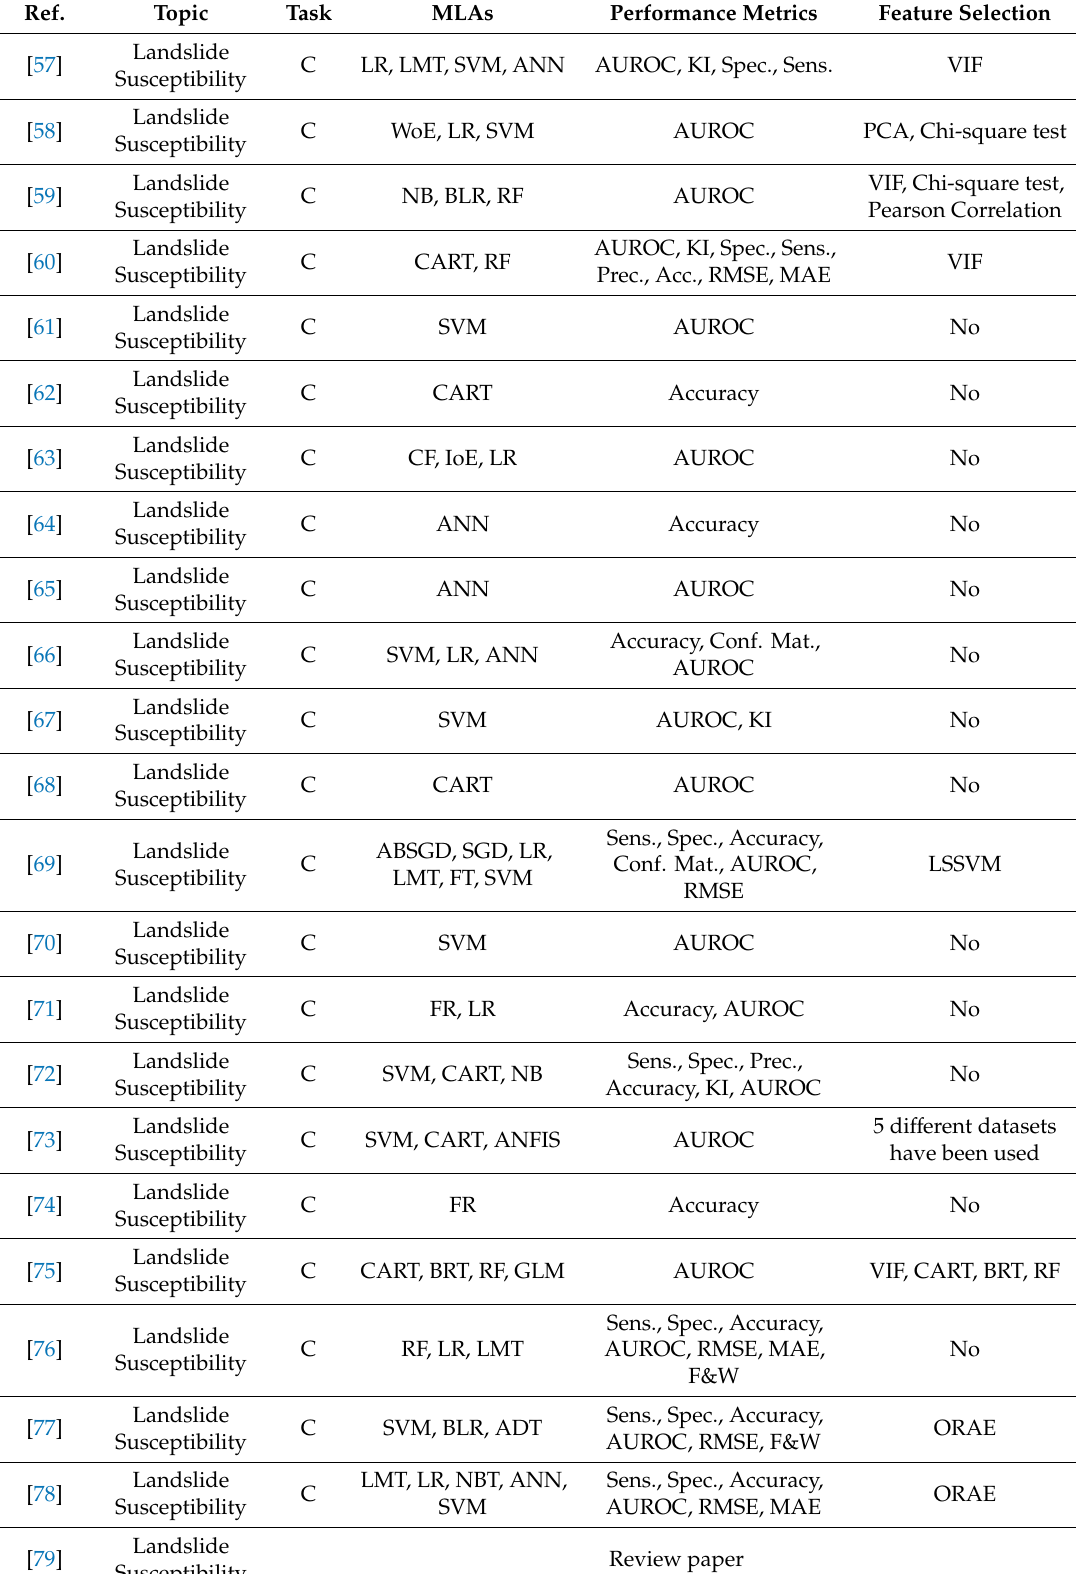
Table 1. Review of papers addressing environmental-related issues by Machine Learning.